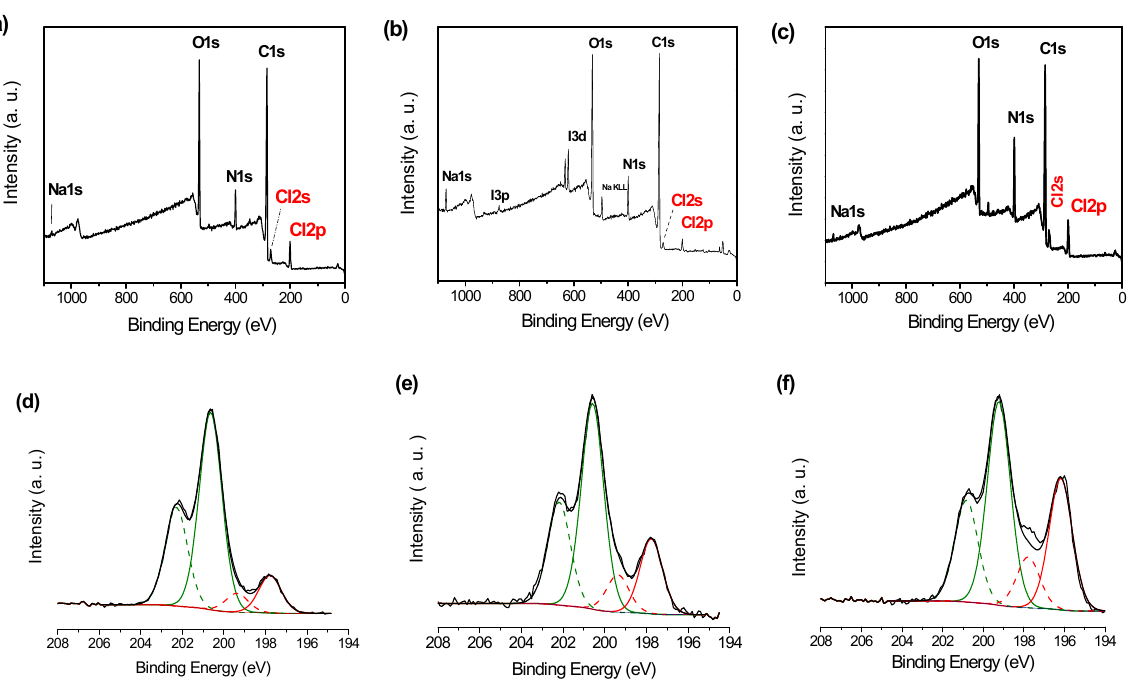
Figure 5. XPS survey spectra ( a – c ) and high-resolution Cl2p spectra ( d – f ) after chlorination of ( a , d ) PDA–O 2 , ( b , e ) PDA–IO 4 − and ( c , f ) PDA–PEI. PDA–O 2 , ( b , e ) PDA–IO 4 − and ( c , f )